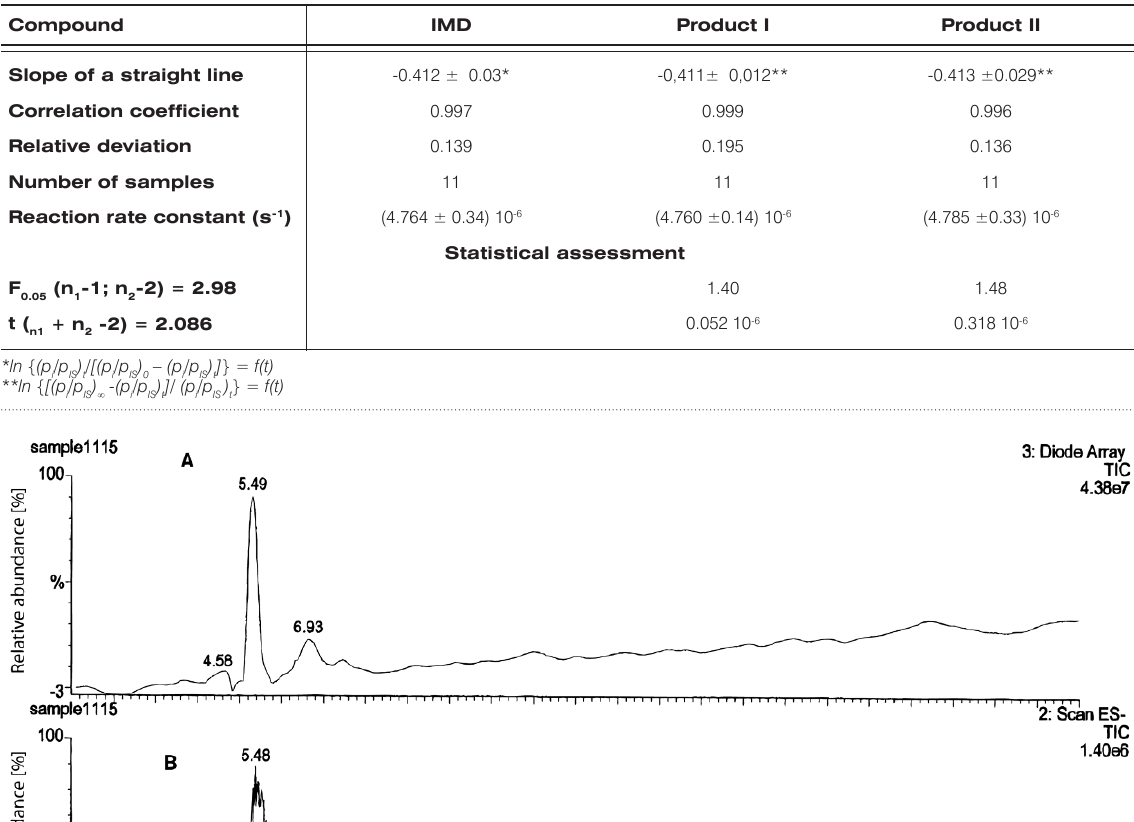
Table 3. Parameters of IMD degradation and its degradation products formation under T = 363 K and RH = 76.4%.